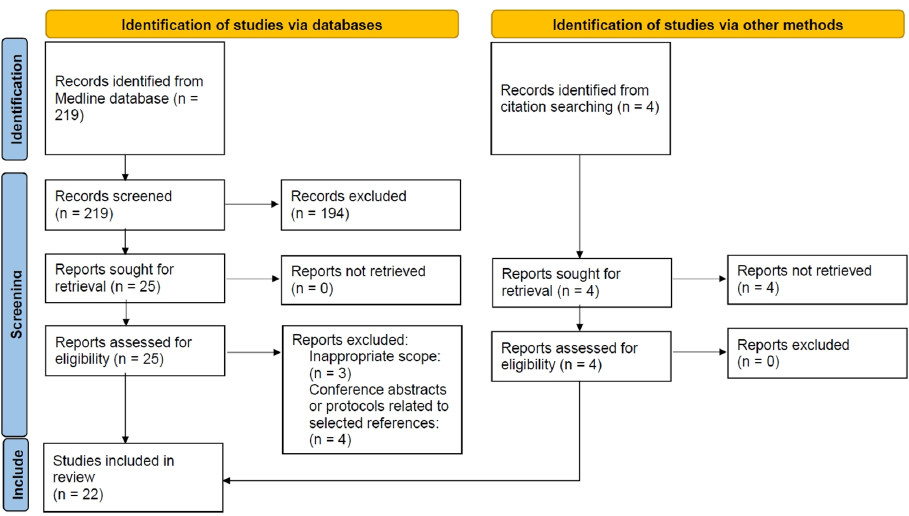
Figure 1. Flow diagram of the literature search and selection process of studies, adapted from PRISMA 2020 [38].